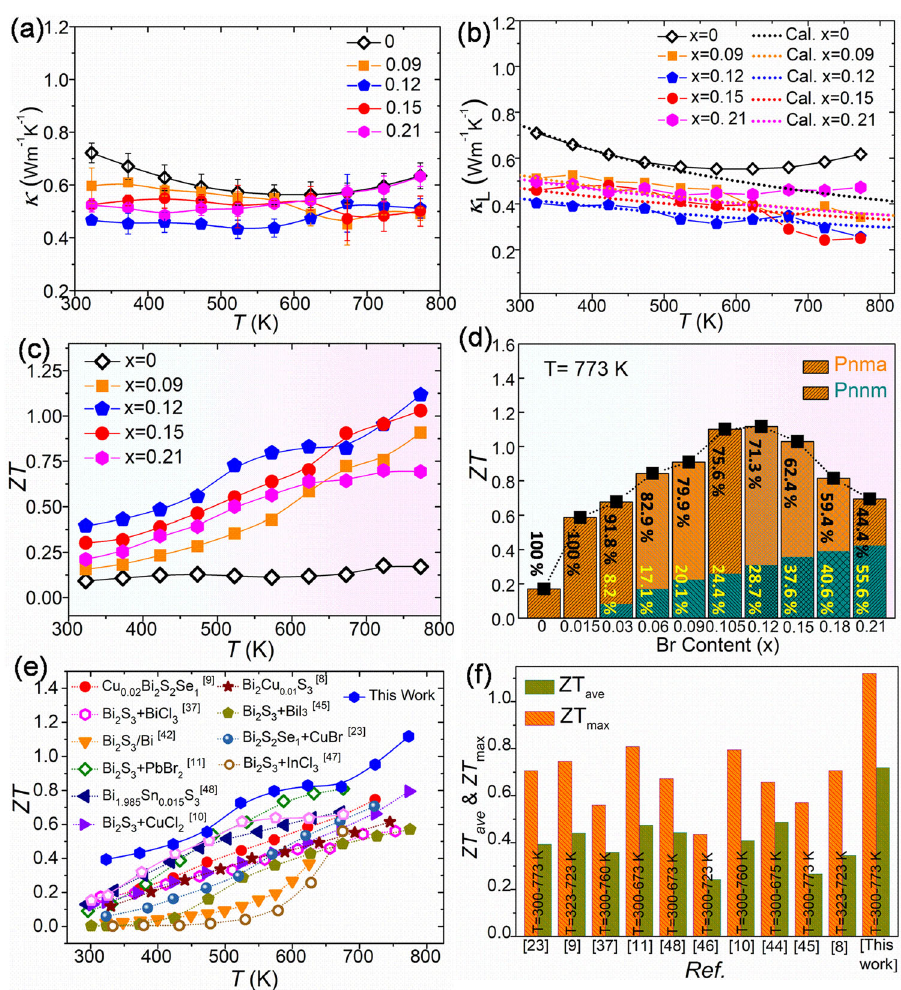
Fig. 7 Thermal transport properties and ZT values. a Temperature dependence of the total thermal conductivity ( κ ) of Bi 2 Se 1-x Br x S 2 ( x = 0, 0.09, 0.12, 0.15, 0.21). Error bars were estimated from the repeatability of the experimental result; three measurements were carried out for each material. b Experimental (symbols) and theoretically derived (dotted lines) lattice thermal conductivity ( κ L ) of Bi 2 Se 1-x Br x S 2 ( x = 0, 0.09, 0.12, 0.15, 0.21). c ZT values of Bi 2 Se 1-x Br x S 2 ( x = 0, 0.09, 0.12, 0.15, 0.21). d ZT values as a function of Br content, with the bars showing the Pnma and Pnnm phase